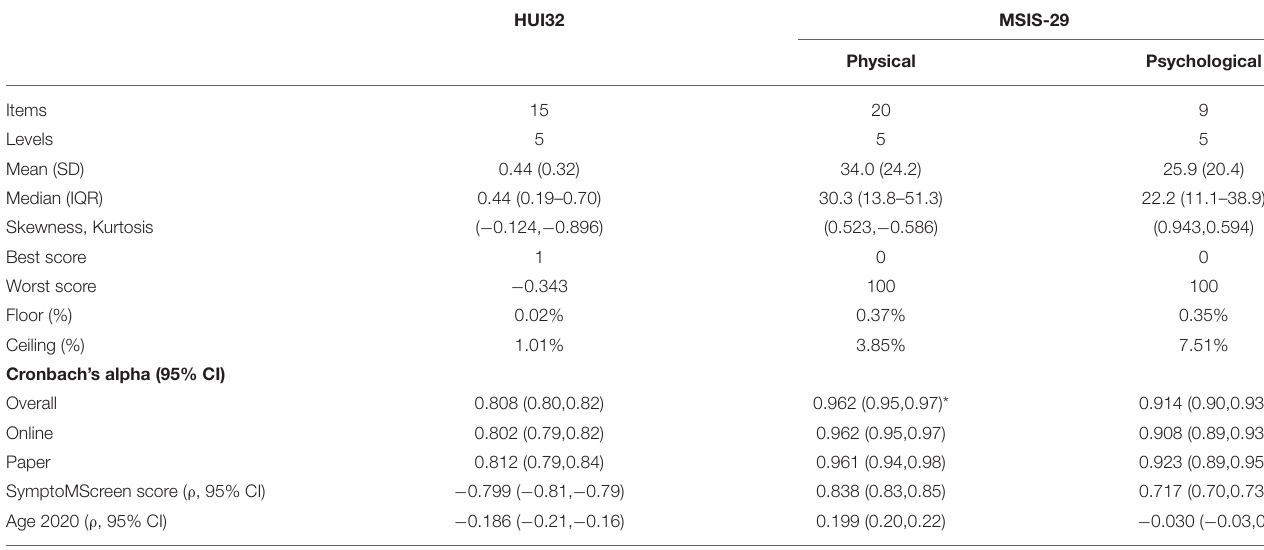
TABLE 2 | Acceptability and reliability of the measures of health-related quality of life.